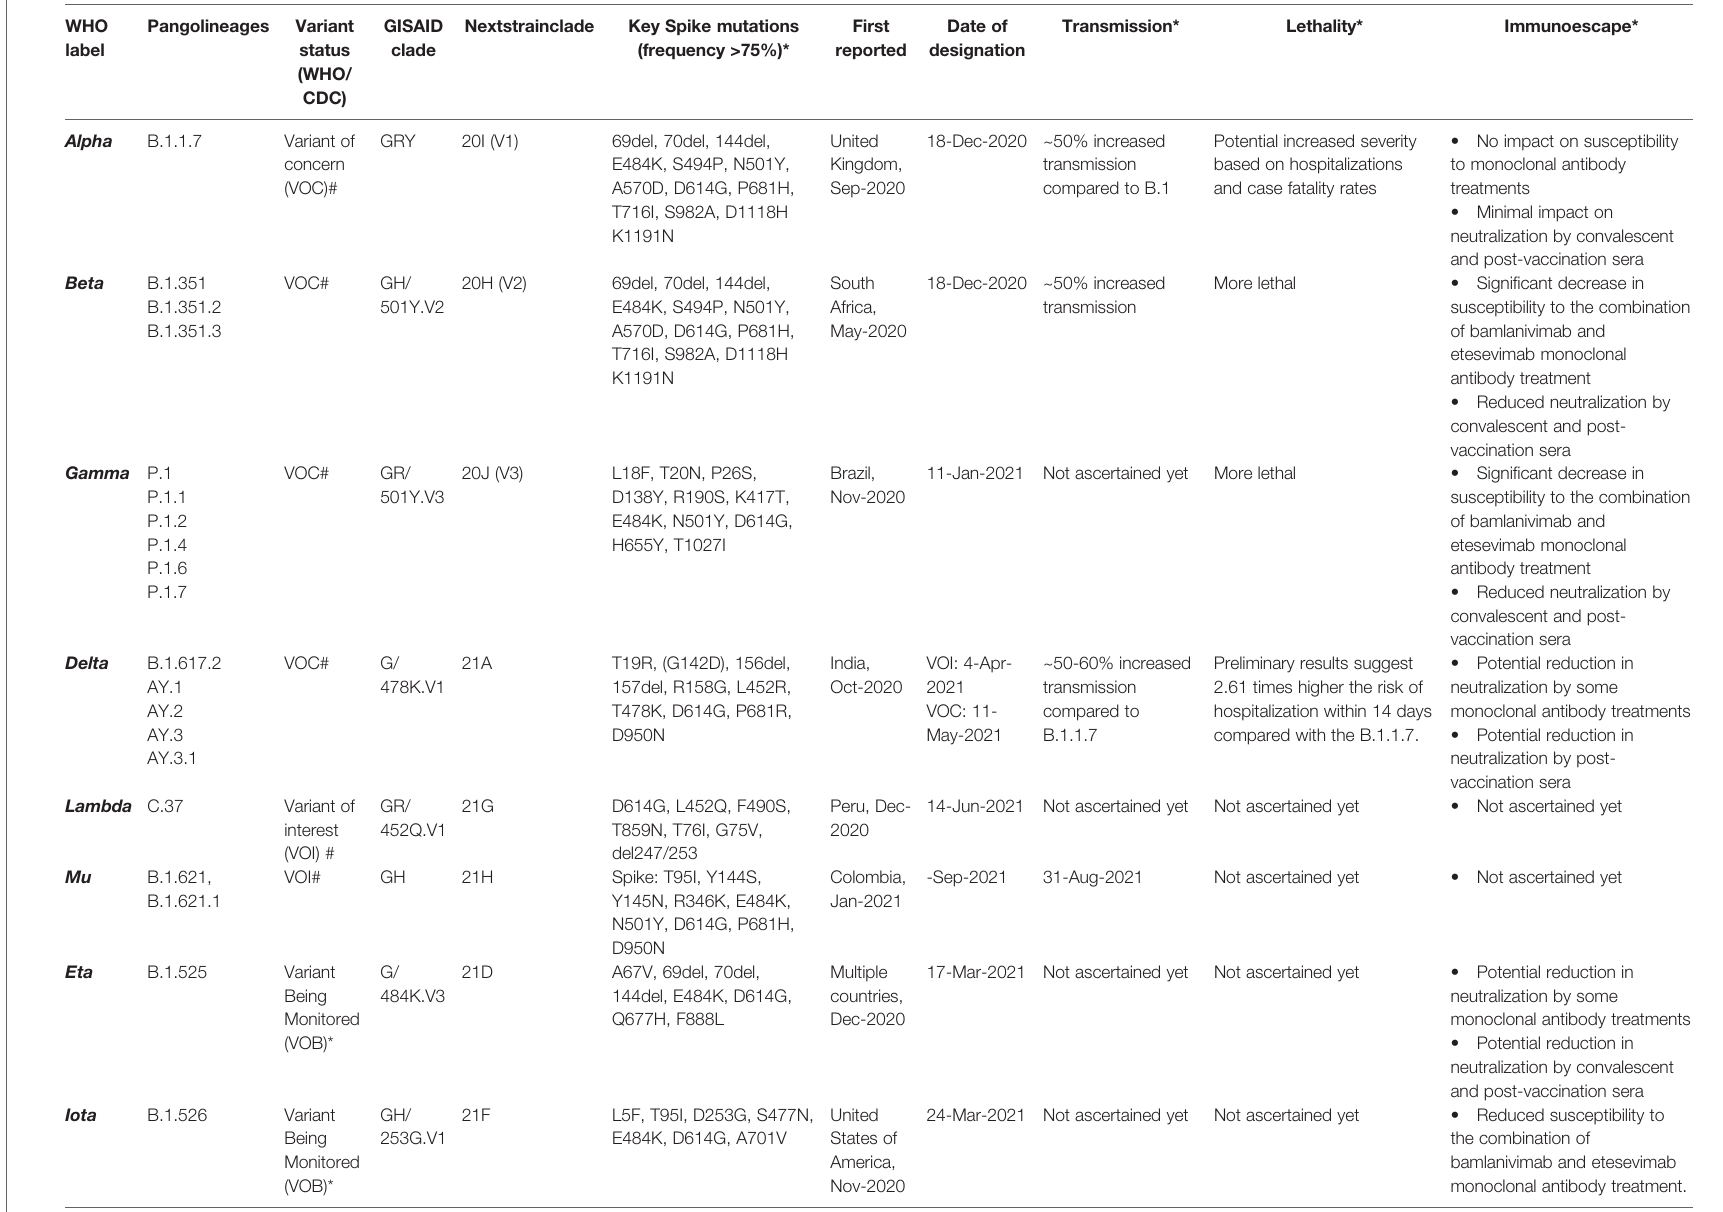
TABLE 2 | Emerging severe acute respiratory syndrome coronavirus 2 (SARS-CoV-2) variants across the globe and their clinical – epidemiological